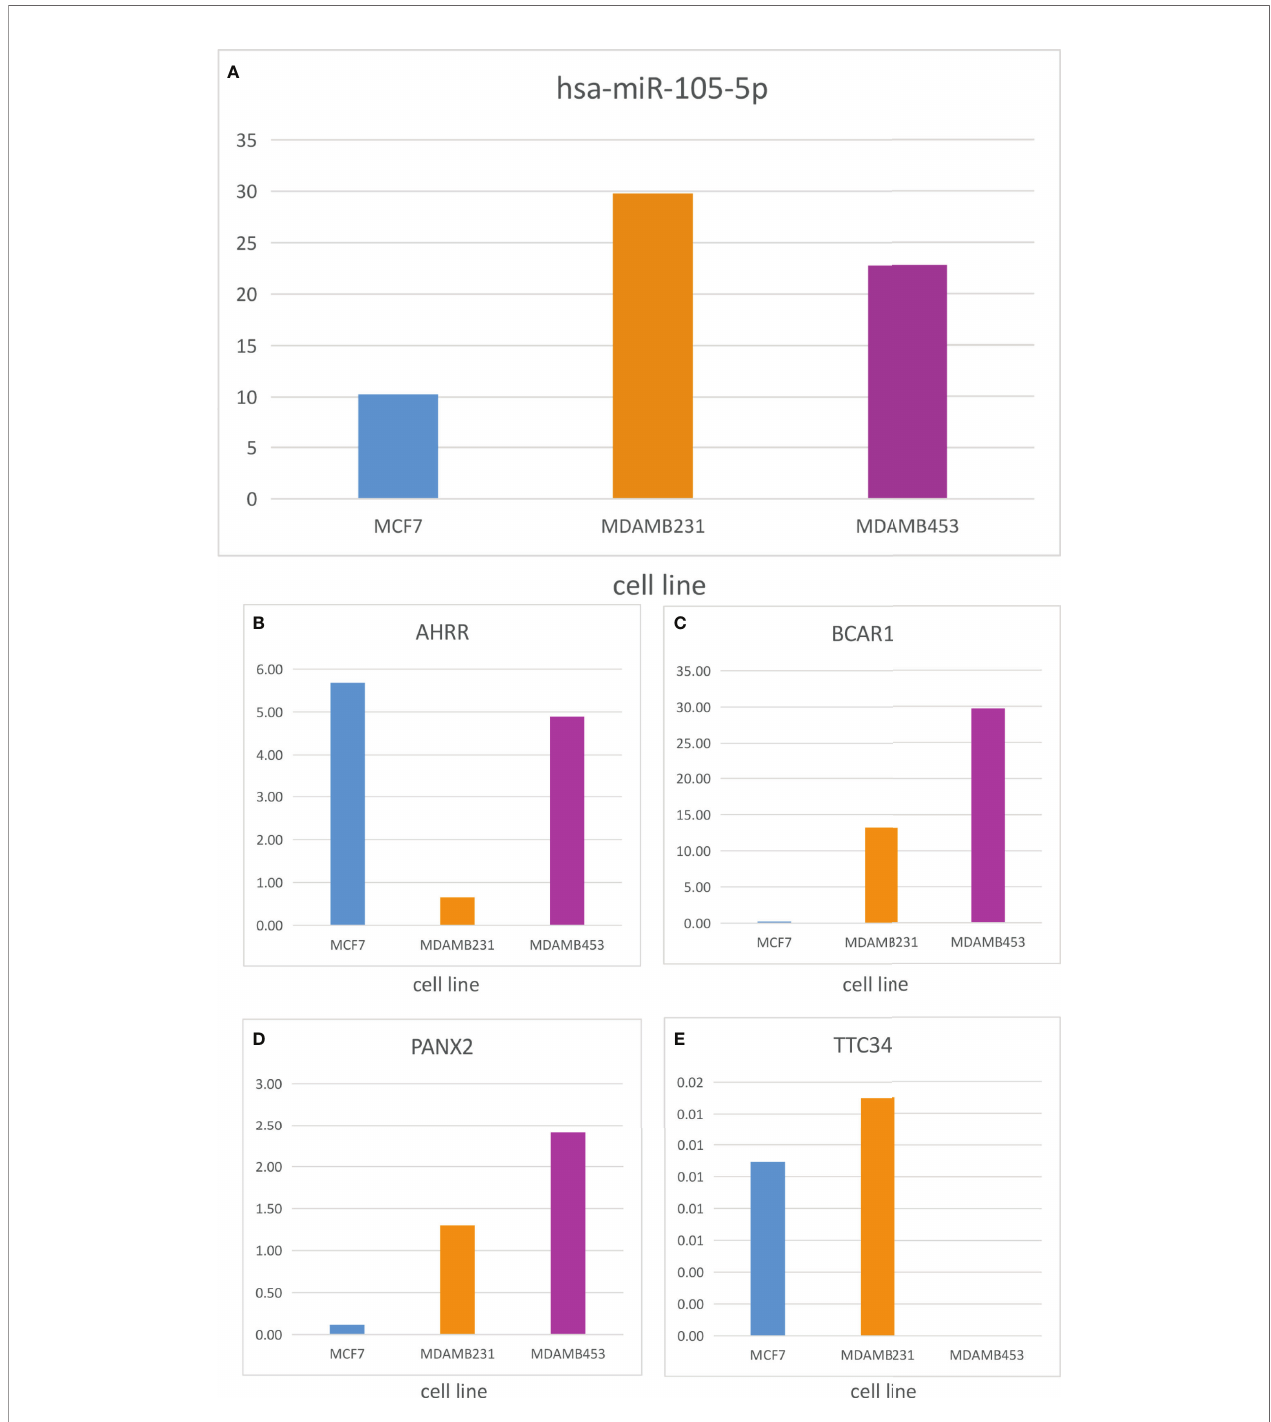
FIGURE 7 | Expression level of the 5 RNAs between highly metastatic cell lines (MDAMB231, MDAMB453) and lowly metastatic cell lines (MCF7). hsa-miR- 105-5p (A) , AHRR (B) , BCAR1 (C) , PANX2 (D) , TTC34 (E)